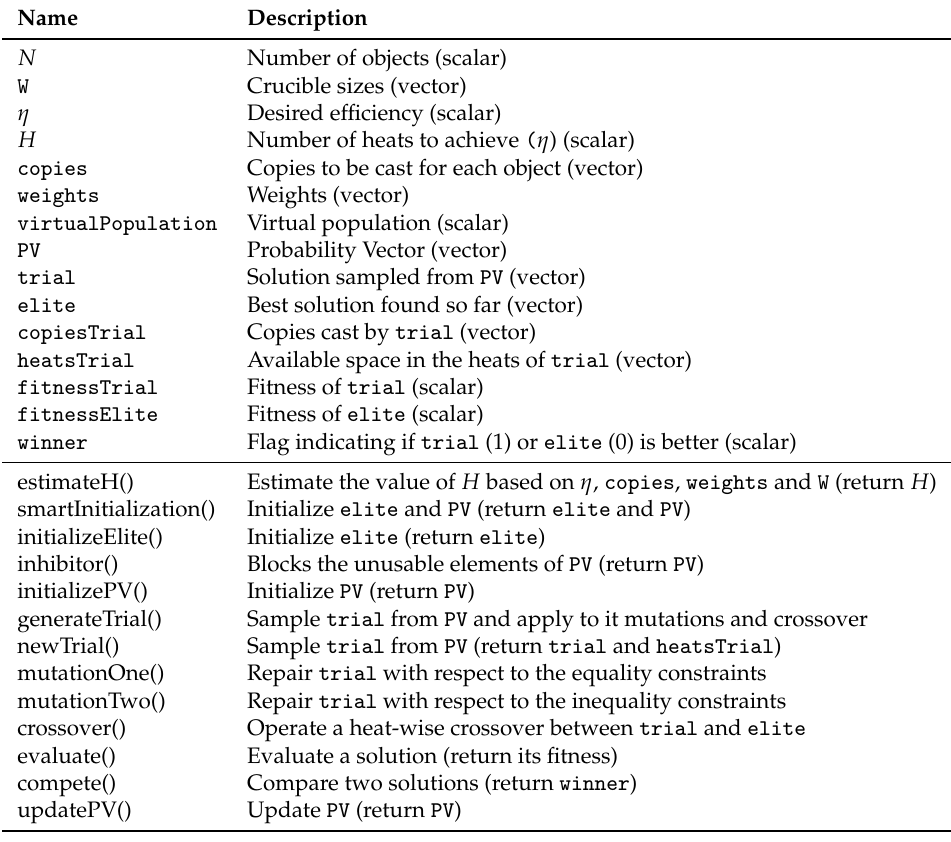
Table 3. Variables and functions used in the discrete cGA.